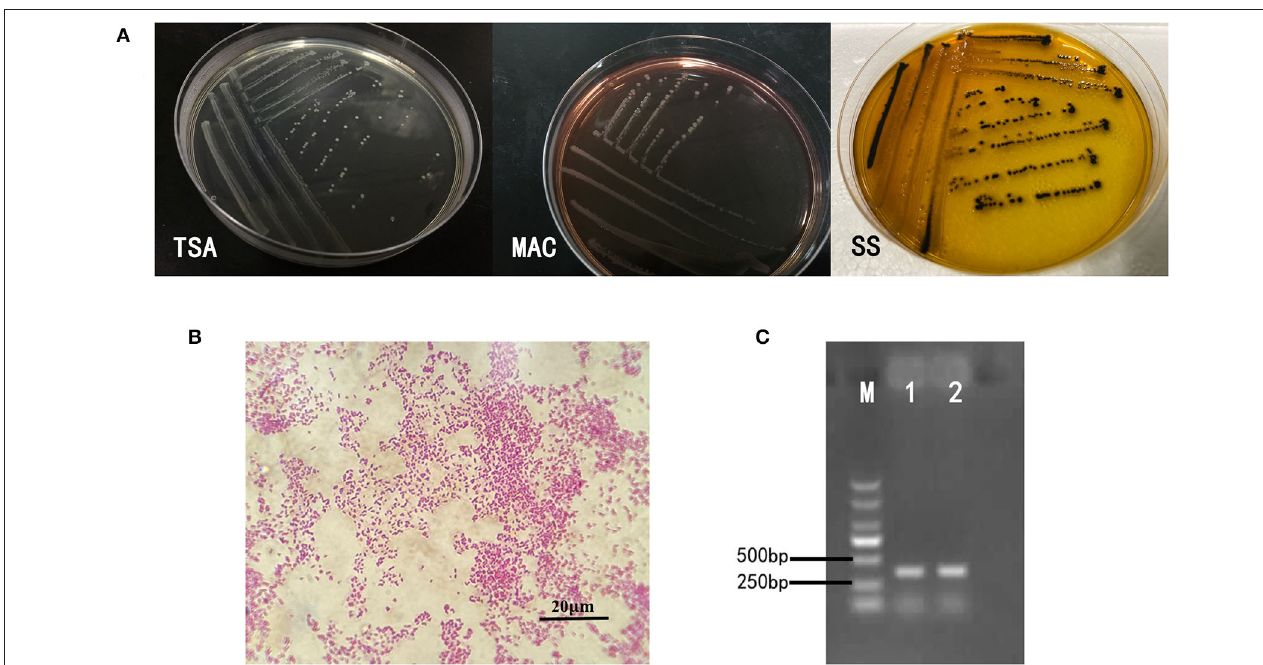
FIGURE 1 | Isolation and identification of bacteria. (A) On the TSA medium, the bacteria presented a round, slightly raised, rounded and smooth surface, translucent colonies. Round translucent colonies with smooth edges appear on MAC identification medium. The strains on SS identification medium were round, slightly convex, with smooth and neat edges, and the center of the colony was black. (B) The bacteria were short shaped, without capsule and spores. Most of them are single. It was Gram-negative bacilli. (C) The invA gene-specific to Salmonella was used to amplify the DNA of the isolated strain by PCR, and the product size of the target fragment was 374 bp, which was the same as that of the reference strain of S. enteritidis